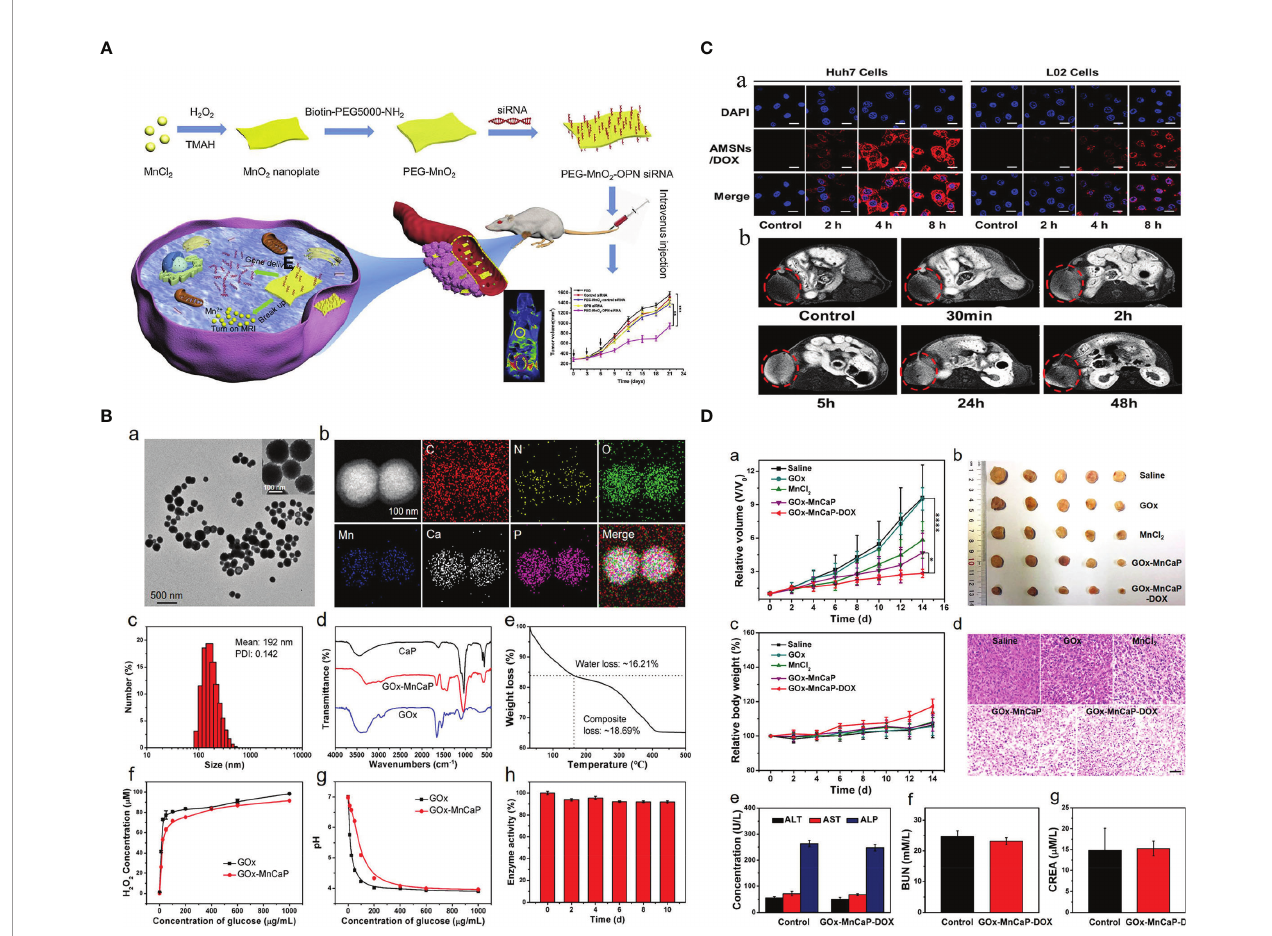
FIGURE 2 | Mn-based hybrid nanomaterials as carriers for drug delivery and their application in tumor. (A) Schematic illustration of PEG-MnO 2 -OPN siRNA (20). (B) Preparation and characterization of GOx-MnCaP-DOX, glucose oxidase (GOx) with manganese-doped calcium phosphate (MnCaP), and doxorubicin (DOX) (39). (C) Tumor cell-selective uptake analysis by confocal laser scanning microscope and in vivo tumor homing behavior evaluation by T1-weighted MRI of arginine-rich manganese silicate nanobubbles loading DOX (AMSNs/DOX) (49). (D) The in vivo antitumor ef fi cacy of GOx-MnCaP-DOX on the 4T1 tumor-bearing mouse model (39). OPN, Osteopontin; GOx, Glucose; MnCaP, manganese-doped calcium phosphate; DOX, doxorubicin; AMSNs, Arginine-rich manganese silicate